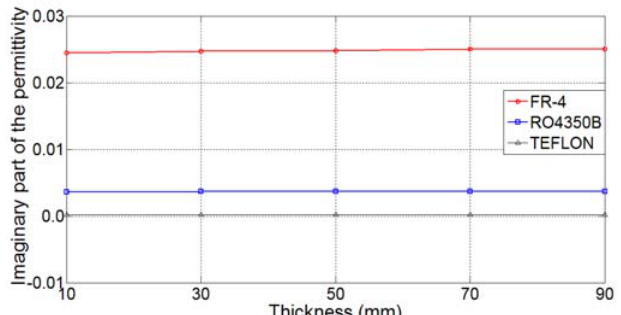
Figure 9: The imaginary part of the complex relative permittivity of material samples is estimated by the MUSIC algorithm.